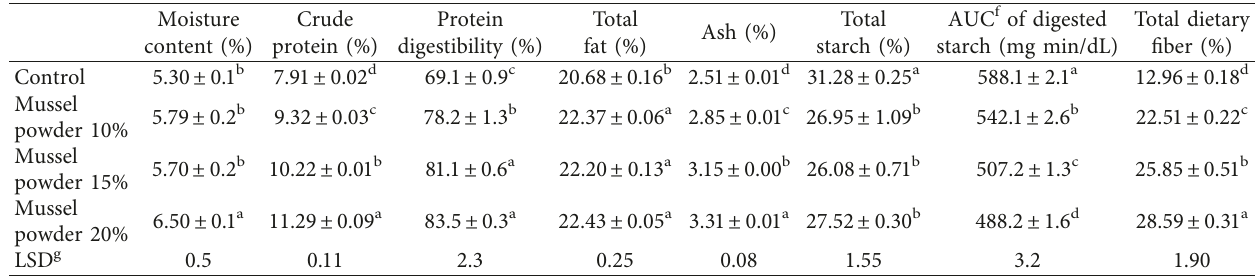
Table 2: Proximate analysis, protein digestibility, and AUC of digested starch of the fortified biscuits prepared from wheat-purple rice flour blends mixed with mussel powder and spices e